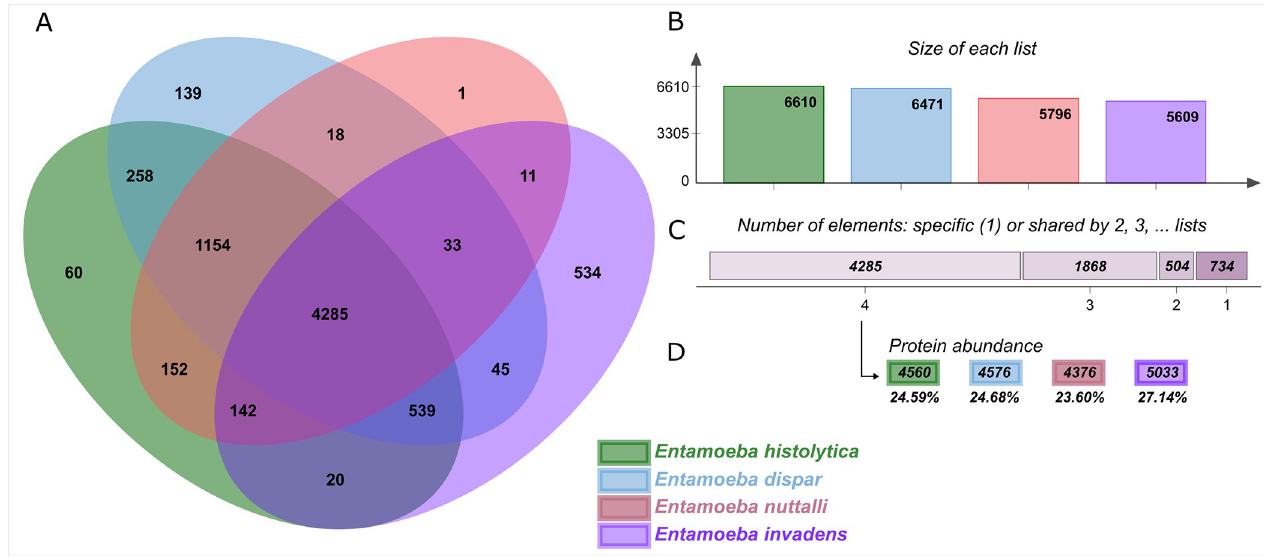
Fig 2. Orthologous proteins shared between Entamoeba strains. A) Orthologous clusters of whole proteomes. B) The bar plot graph shows the number of orthologous clusters by organism. C) The plot indicates the number of clusters that are organism specific or shared by 2, 3, or 4 organisms. D) For the 4,285 clusters shared by 4 organisms, the protein abundance levels are shown for each